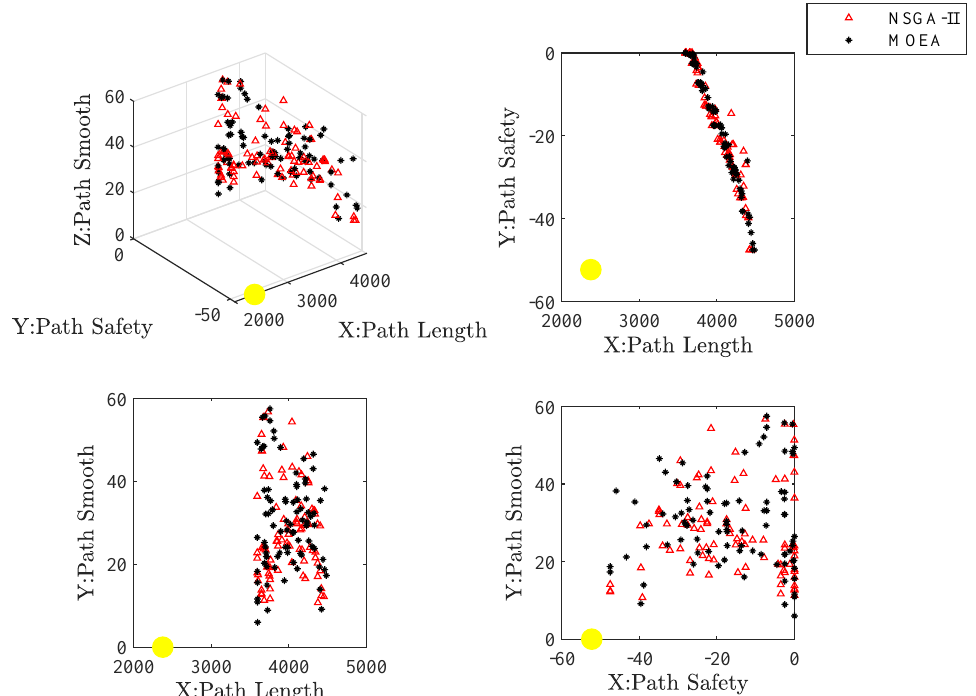
Figure 27. Based on Figure 11E, the approximate Pareto fronts generated by the two algorithms NSGA-II and MOEA. The sub-figure of the upper left corner shows the image of the approximate Pareto front in three-dimensional space. The remaining three sub-figures are the projections of the approximate Pareto front in the two-dimensional space.